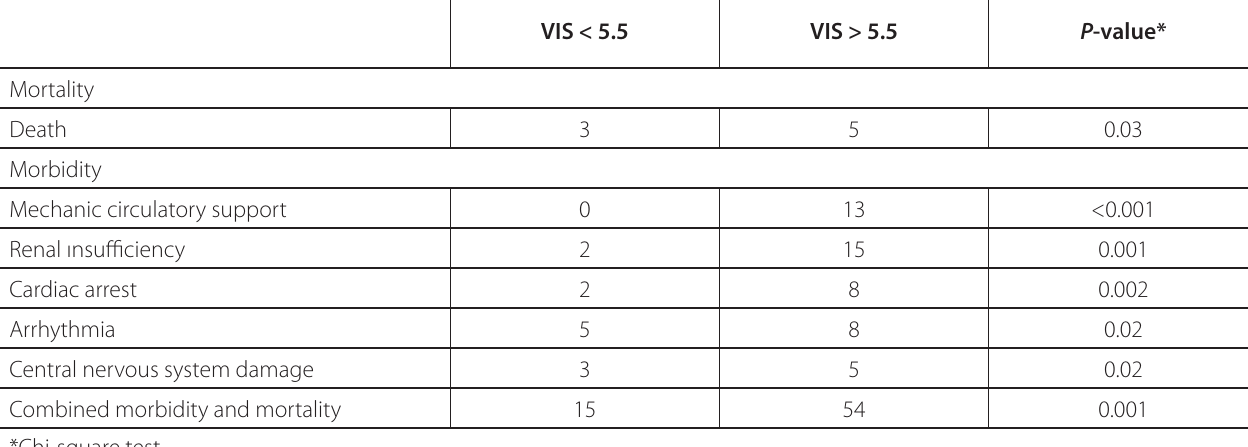
Table 2 . Distribution of combined morbidity and mortality according to VIS